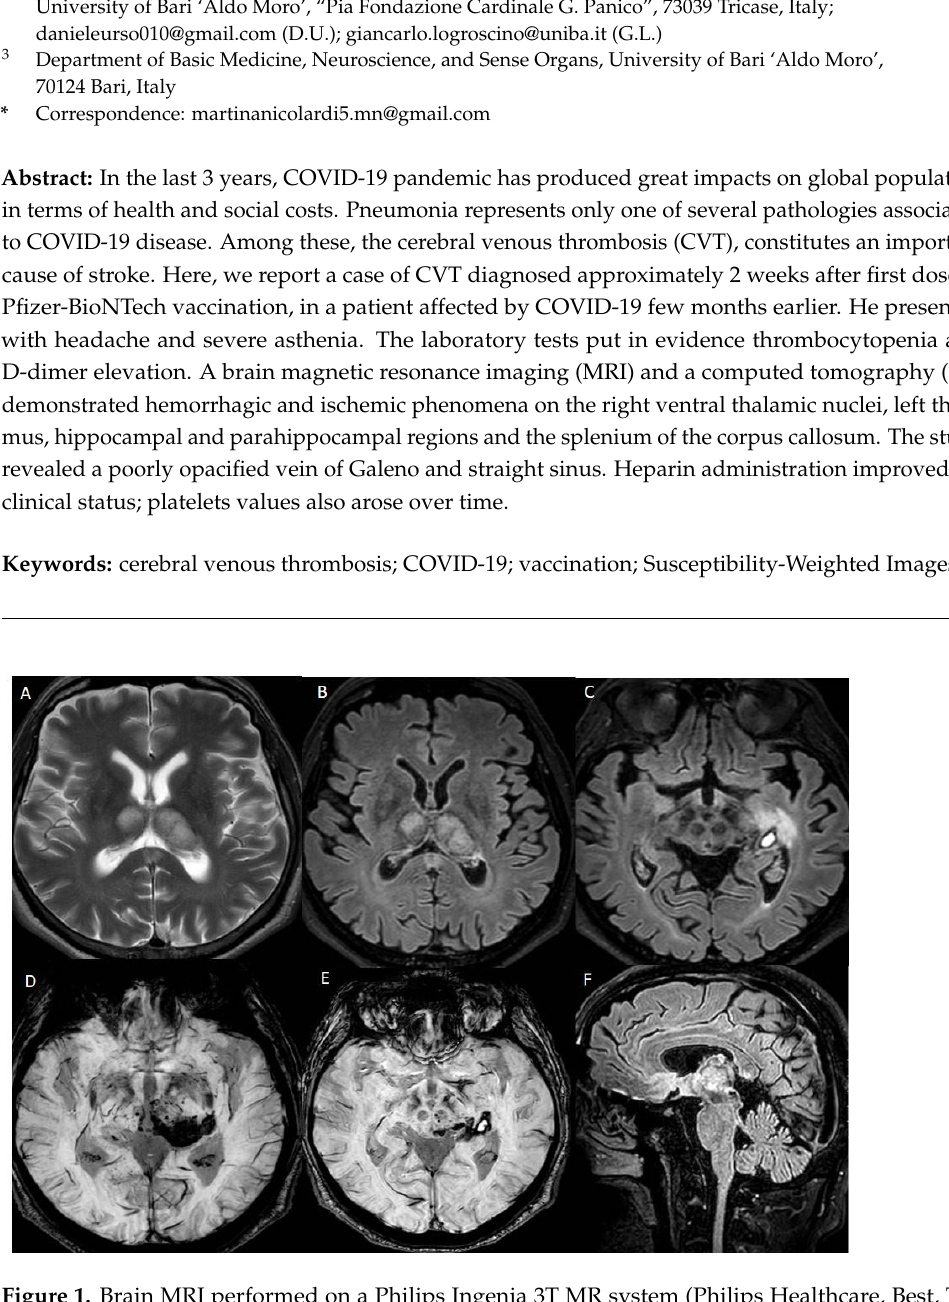
Figure 1. Brain MRI performed on a Philips Ingenia 3T MR system (Philips Healthcare, Best,